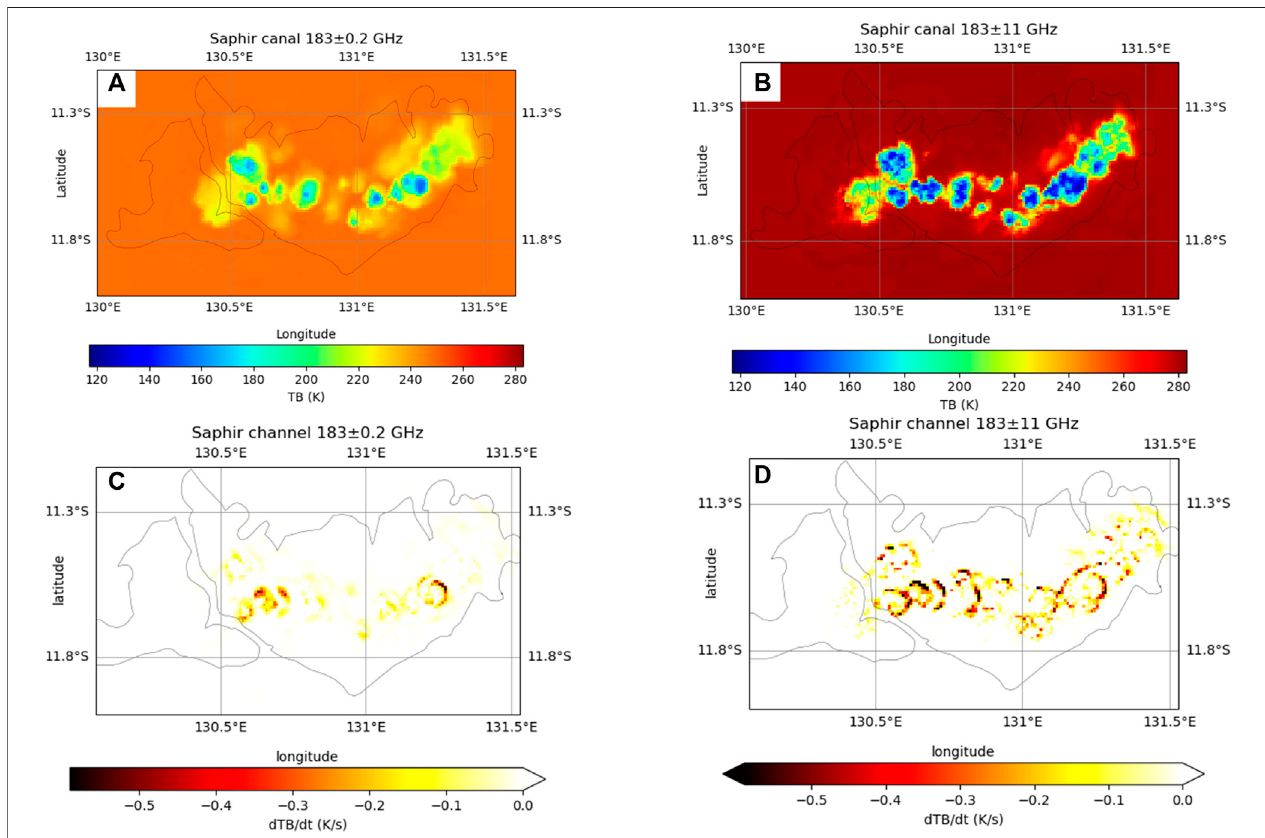
FIGURE 5 | Snapshots from the Meso-NH HEC simulations (model resolution at 1 km). Top panels show the Tb (K) for (A) C1 and (B) C6 channels, and bottom panels show the dTb/dt for (c) C1 (183.31 ± 0.2 GHz) and (d) C6 (183.31 ± 11 GHz) channels, for atime interval ofdt =1min. On fi gures (C) and (D) ,the whiteareas are masked using a deep convection criterion (following Rysman et al, 2016 ) as well as dTb/dt < 0 (see text for details).